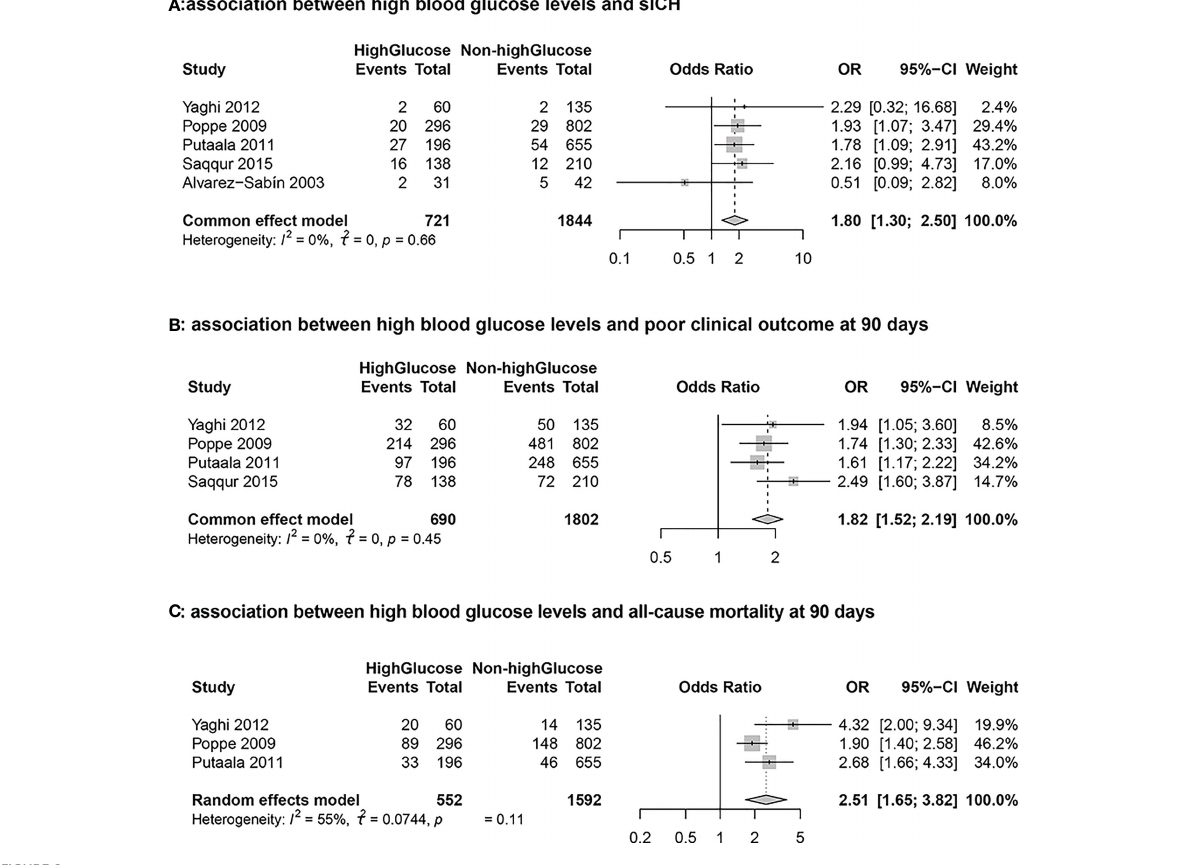
FIGURE 2 Forest plots for the meta-analyses of the outcomes between high glucose and non-high glucose groups. (A) : Association between hyperglycemia and symptomatic intracranial hemorrhage (sICH) (B) : Association between hyperglycemia and poor clinical outcome at 90 days (C) : Association between hyperglycemia and all-cause mortality at 90